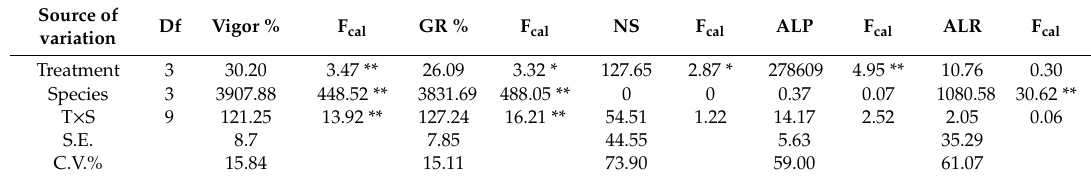
Table 5. ANOVA of accelerated aging test in four plant species under UV-C radiation. Source of variation